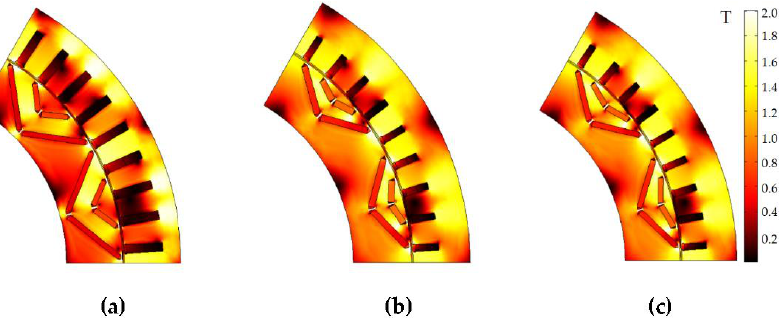
Figure 7. Modification of the geometry and magnitude of the flux density in the IPMSM during the